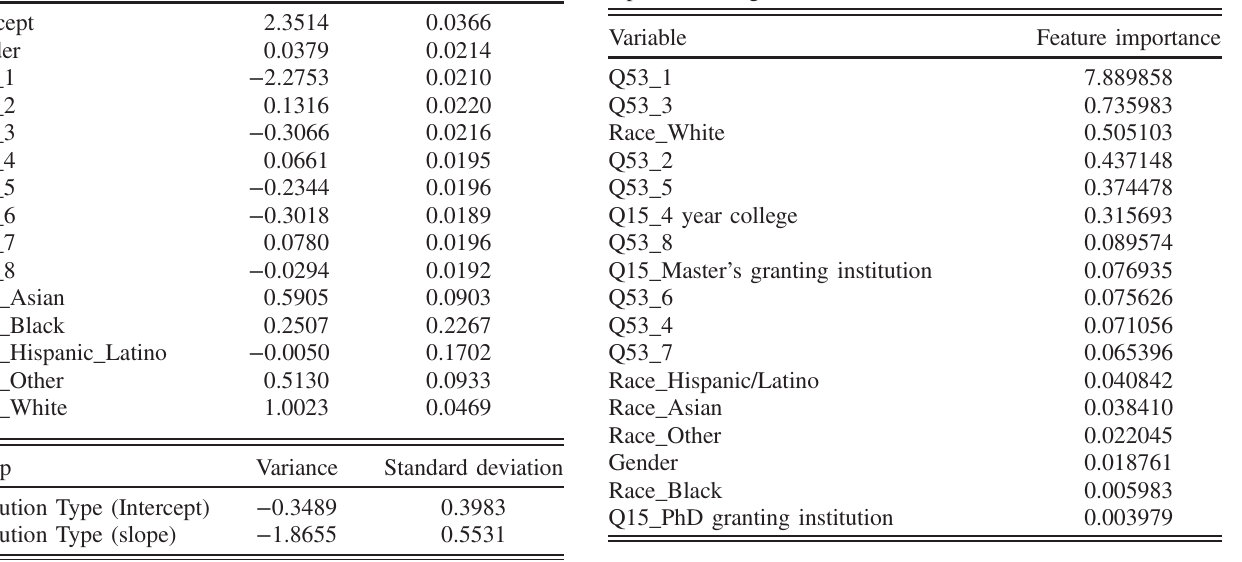
TABLE X. Feature importances for the gradient boosted model for the E-CLASS study. The feature importance in this table represents the gain